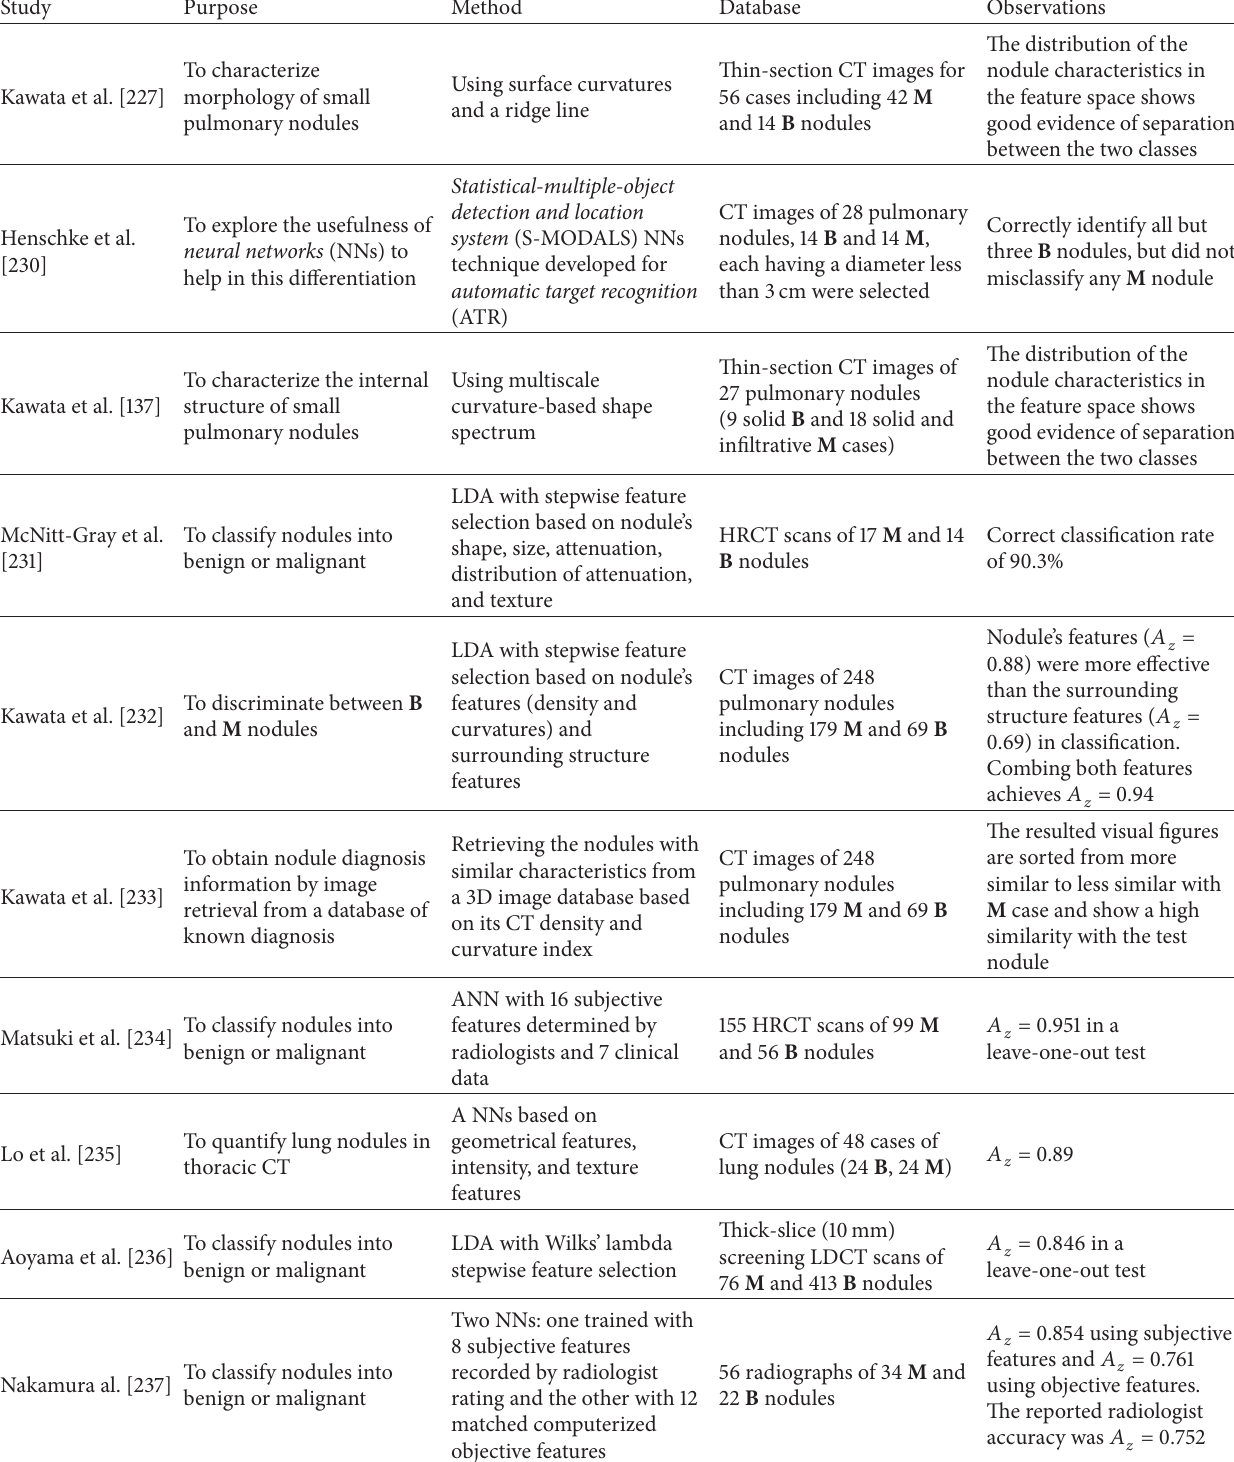
Table 9: Classification between malignant ( M ) and benign ( B ) nodules based on shape and appearance features.